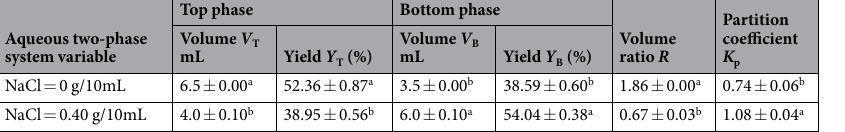
Table 3. Effect of NaCl on the separation of peptides. 1 The data (mean ± standard deviation) derived from 3 replicates as described in the Materials and Methods section. 2 The difference between the mean values with the same superscript letter in the same column was significant at a 95% confidence interval.